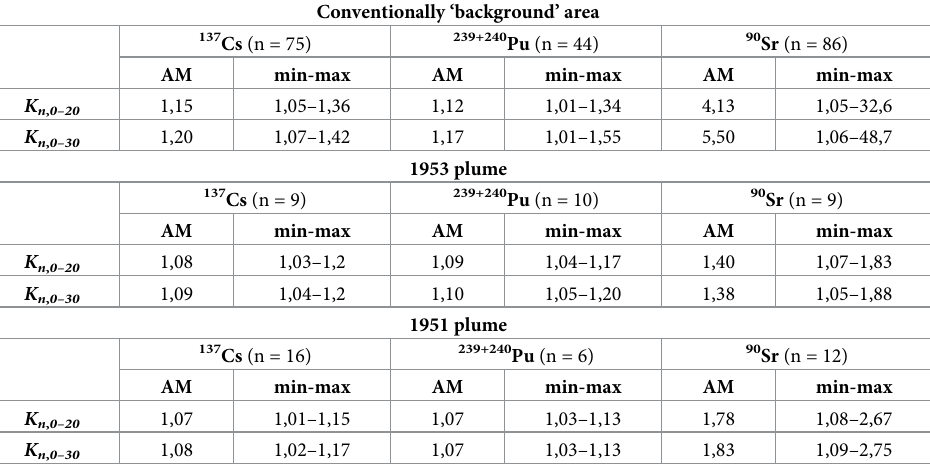
Table 3. Values of coefficients ( K n , 0–20 and K n , 0–30 ), which determine the ratio of radionuclide activity concentra- tions in the soil cover layer down to 20 and 30 cm deep to the activity concentration of a radionuclide in the 0–5 cm